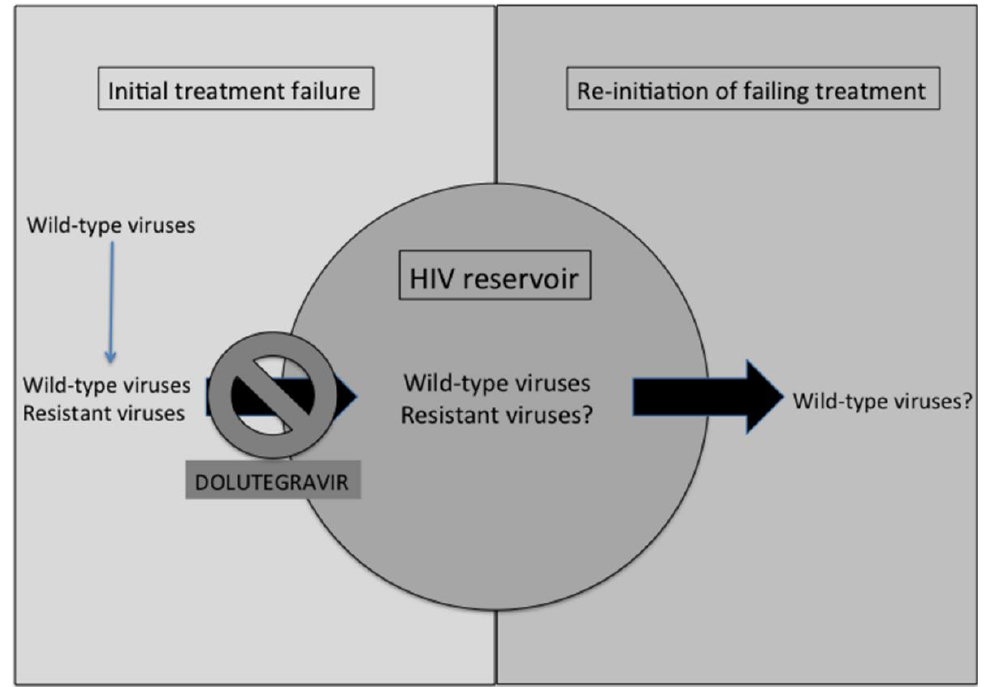
Figure 2. Dolutegravir may inhibit HIV resistant viruses from becoming archived within the viral